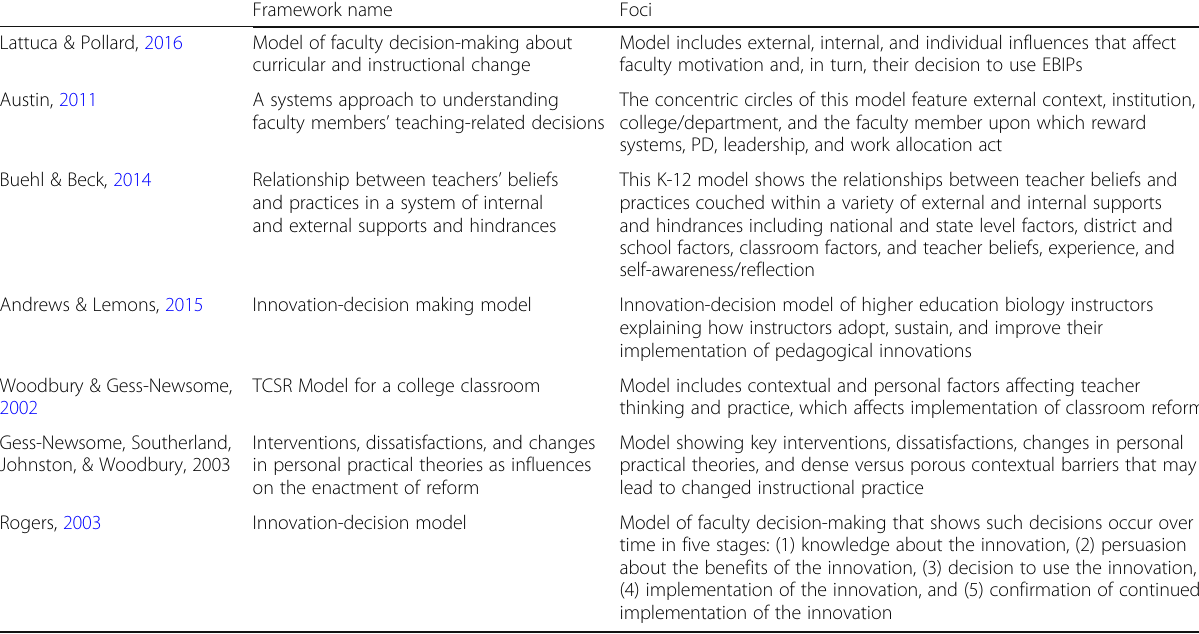
Table 3 List of frameworks related to faculty decision-making and use of EBIPs